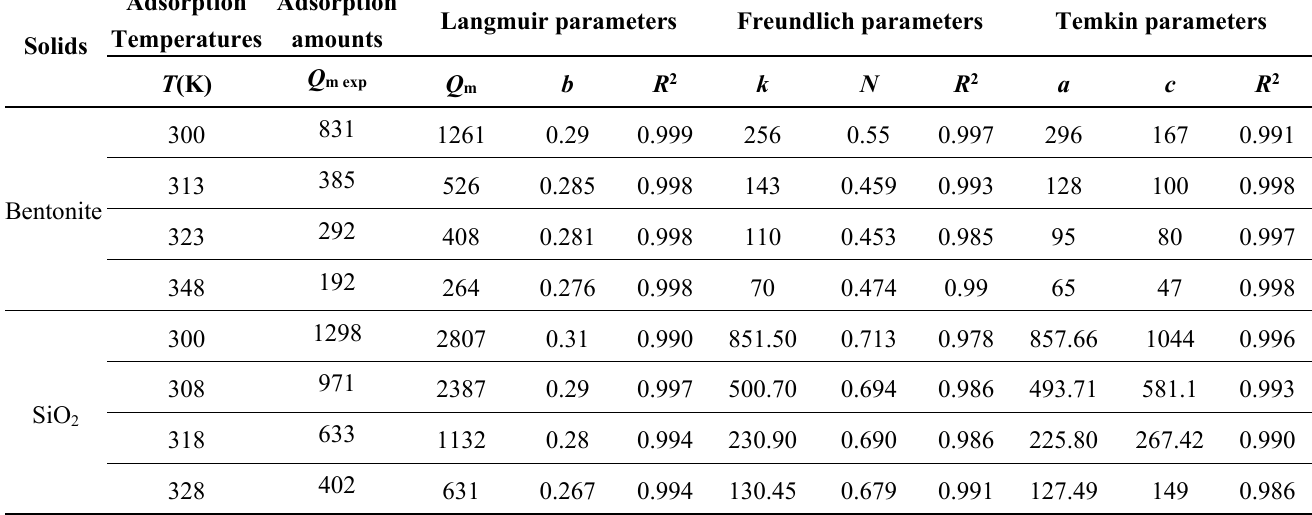
Table 3. Langmuir, Freundlich, and Temkin parameters for adsorption of natural and commercial